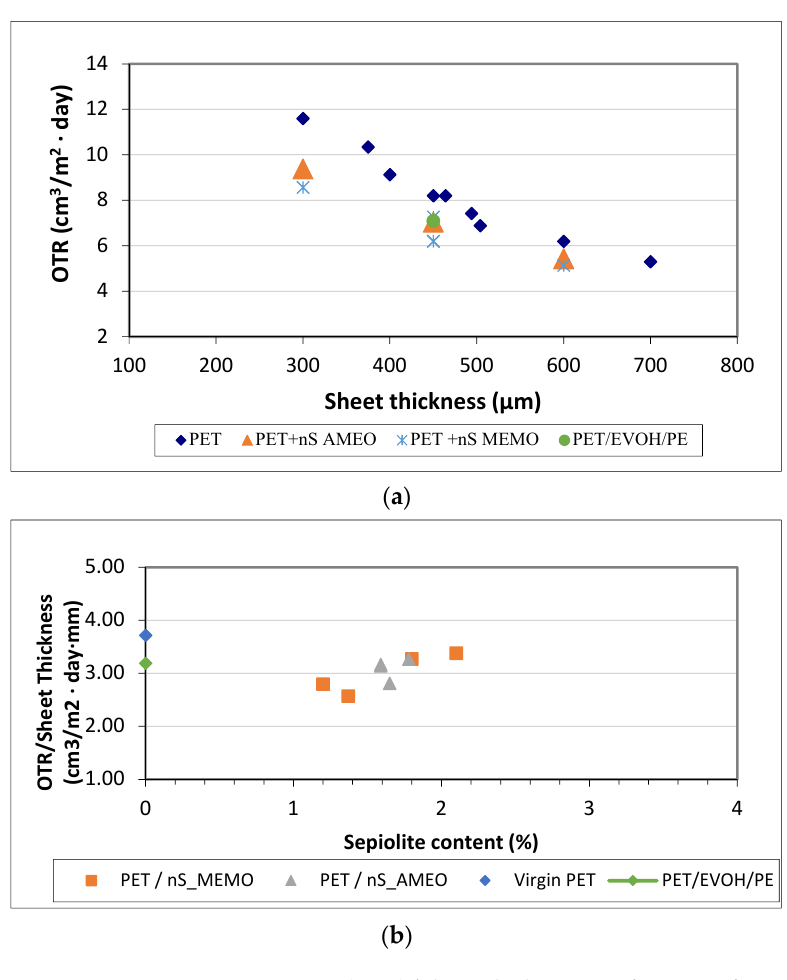
Figure 1. Oxigen transmission rate (OTR)/Sheet Thickness as a function of sepiolite content on the nanocomposite samples ( a ); OTR for nanocomposites as a function of sheet thickness ( b ).